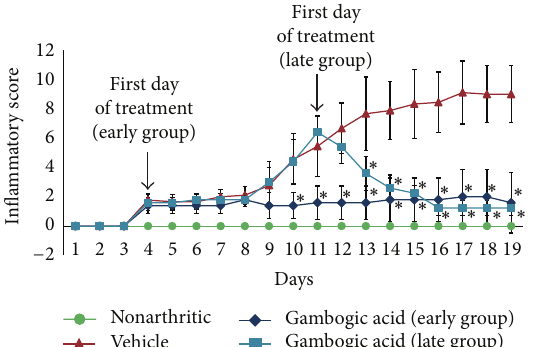
Figure 3: Gambogic acid is able to suppress inflammation throughout time. After 6 days of treatment, the vehicle-injected group increased inflammatory manifestations, whereas, in gambogic acid-treated rats, there was a significant reduction in the inflammatory activity. Arrows indicate the beginning of treatment after 4 and 11 days of dis- ease induction. Differences were considered statistically significant for 𝑃 values < 0.05.